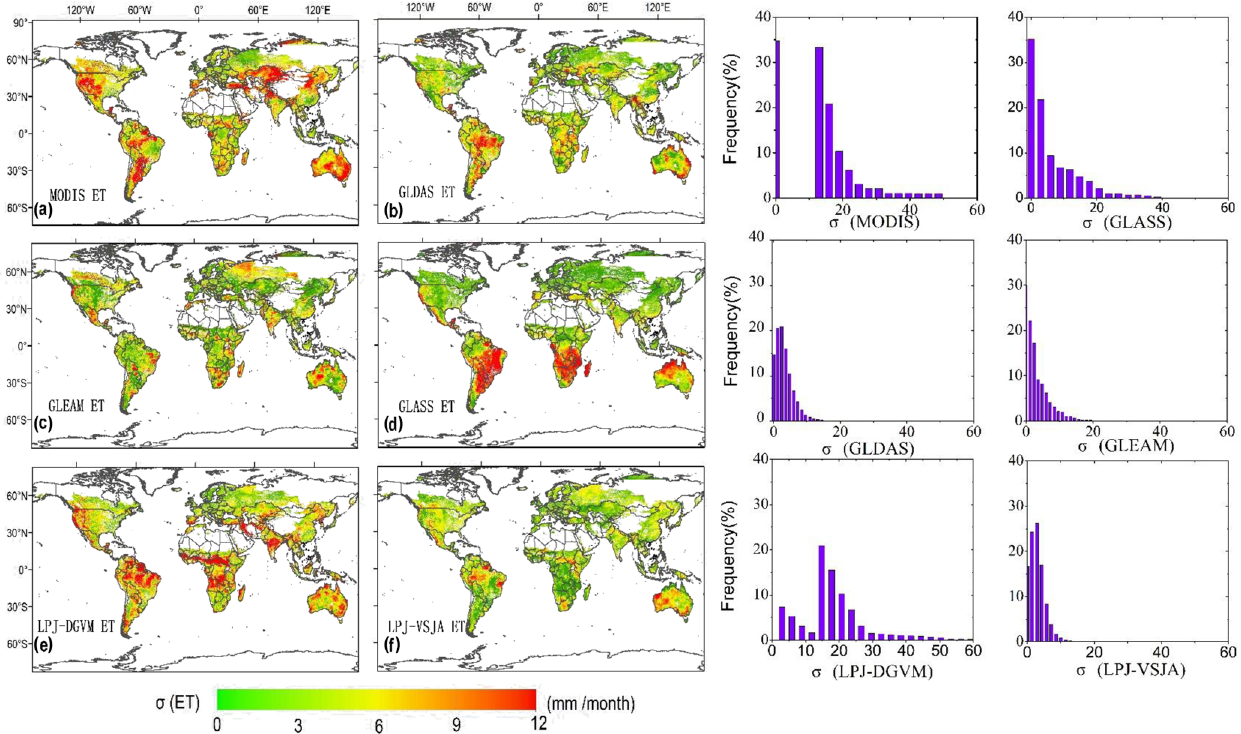
Figure 14. Spatial distribution and histograms of error standard deviation ( σ ) for global ET products: MODIS (a) , GLDAS (b) , GLEAM (c) , GLASS (d) , LPJ-DGVM (e) , and LPJ-VSJA (f)